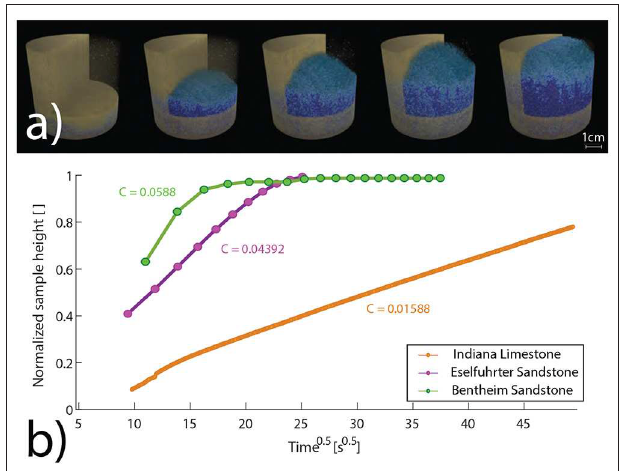
FIGURE 3 | Neutron imaging of the imbibition of porous rocks with D 2 O. (a) Three-dimensional rendering time series of Eselfuhrter sandstone. The sample has been virtually cropped to evidence the progression of waterfront, represented in blue. (b) Progression of the waterfront along the normalized sample height vs. the square root of time for Indiana limestone, Eselfuhrter sandstone and Bentheim sandstone. The slope of the front progression defines the commonly called “sorptivity” constant, here marked as